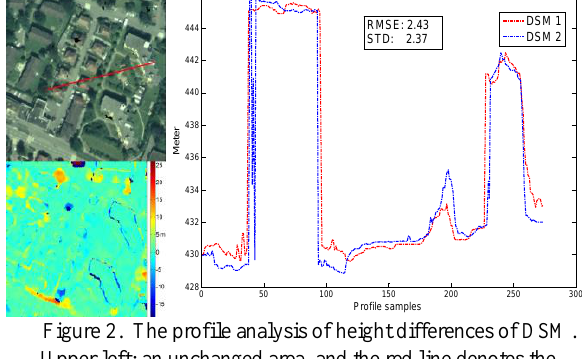
Figure 2. The profile analysis of height differences of DSM. Upper left: an unchanged area, and the red line denotes the analyzed profile; Bottom left: height difference; Right: DSM comparison of the